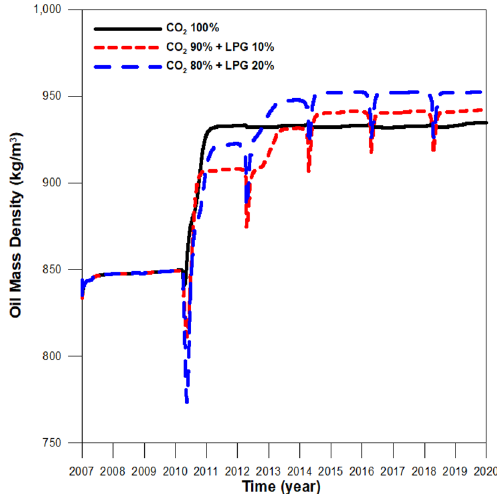
Figure 4. Oil density at the middle of the reservoir during CO 2 and CO 2 -LPG WAG injection.